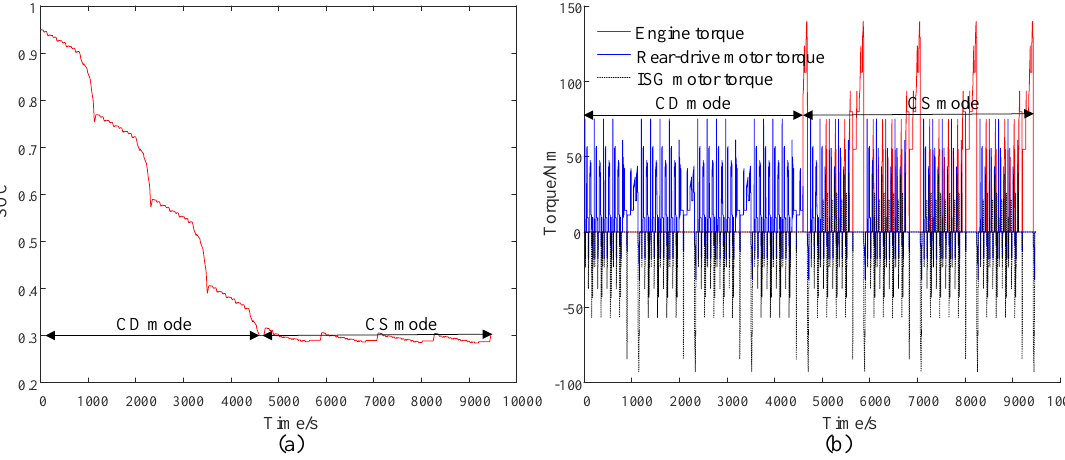
Figure 9. The hardware-in-the-loop (HIL) test results. ( a ) The state of charge’s (SOC’s) change curve. ( b ) The torque’s change curve.